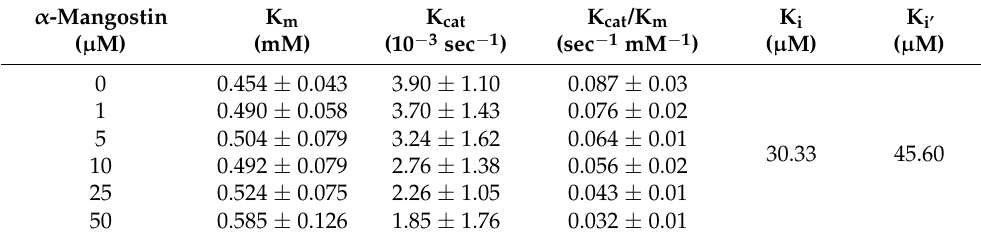
using the Michaelis – Menten plot (Figure 6 A) and nonlinear curve fitting. K cat : enzyme cycle per unit of time; K i : binding constant of the inhibitor to the free enzyme; K i’ : binding constant of the